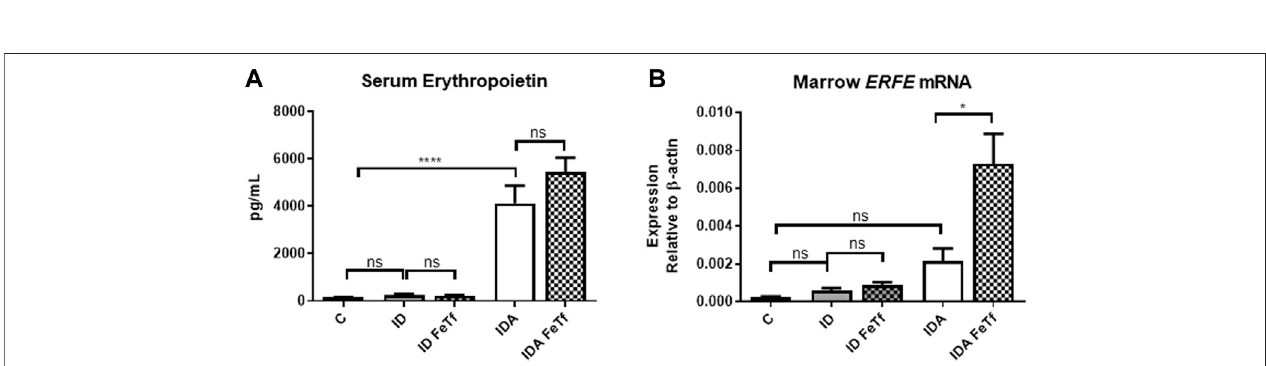
FIGURE 6 | Exogenous transferrin enhances erythropoietin-mediated upregulation of erythroferrone in mice with iron de fi ciency anemia. ID and IDA mice were treated with carrier or holotransferrin. (A) Serum erythropoietin and (B) marrow Erfe mRNA were measured. Serum erythropoietin: for control mice n = 5, for ID cohorts n = 2-5 and for IDA cohorts n = 5 mice per group. Marrow Erfe mRNA: for control mice n = 3, for ID cohorts n = 13 and for IDA cohorts n = 6-7 mice per group. Control micefeda standard 250 ppm Fe dietare included forreference. ppm, parts per million;data represented asmean (SEM).*, p < 0.05; ***, p < 0.005; ****, p < 0.001; ns, non-signi fi